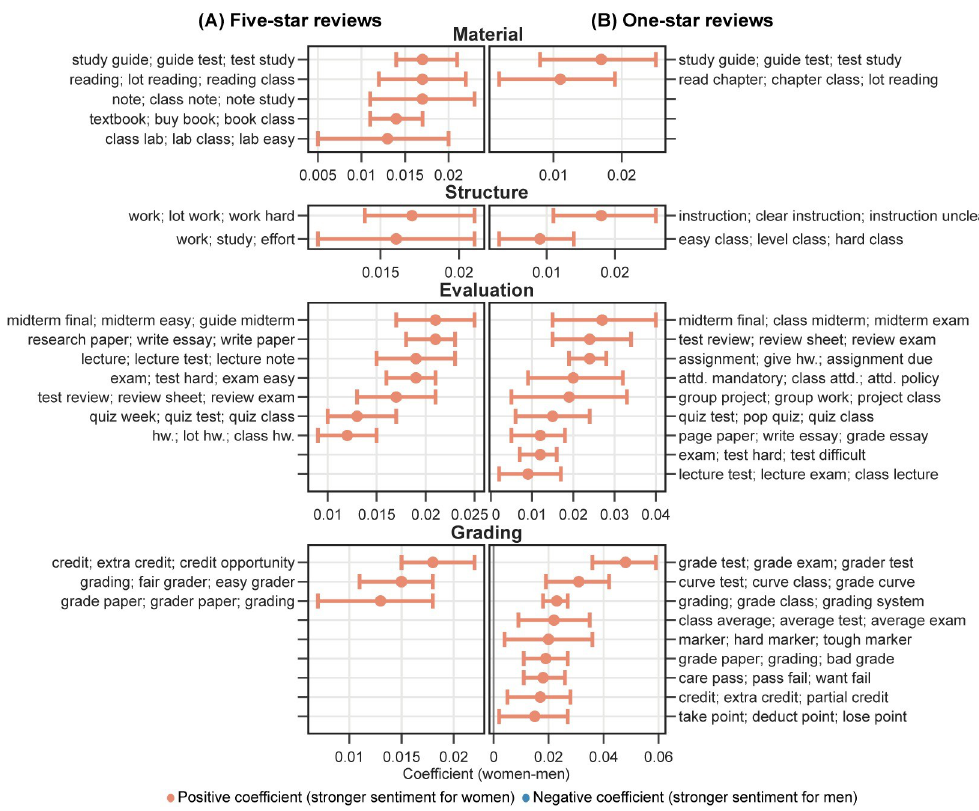
Fig 10. Regression analysis of predicted sentiment scores by course-level topic dimensions. Figure encodings have the same meanings as Fig 9. Only gender-significant topics are shown. Subject dimension is excluded. hw. = homework; attd. = attendance. (A) Regression analysis of five-star reviews based on positive sentiment scores. (B) Regression analysis of one- star reviews based on negative sentiment scores.